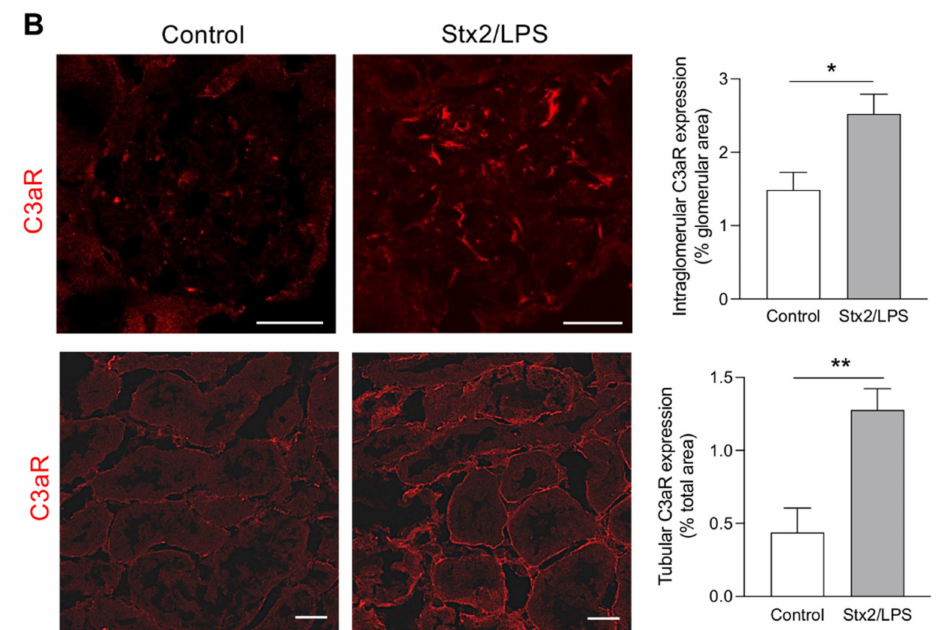
Figure 1. Glomerular and tubular C3 and C3aR staining in Stx2/LPS mice: ( A ) Representative images and quantification of intraglomerular and tubular C3 staining (green) in control and Stx2/LPS- injected mice at 48 h; ( B ) Representative images and quantification of intraglomerular and tubular C3aR expression (red) in control and Stx2/LPS-injected mice. Scale bars: 20 µ m. Results are presented as mean ± SEM (control n = 4, Stx2/LPS n = 7), and unpaired Student’s t test was used. * p < 0.05, ** p <